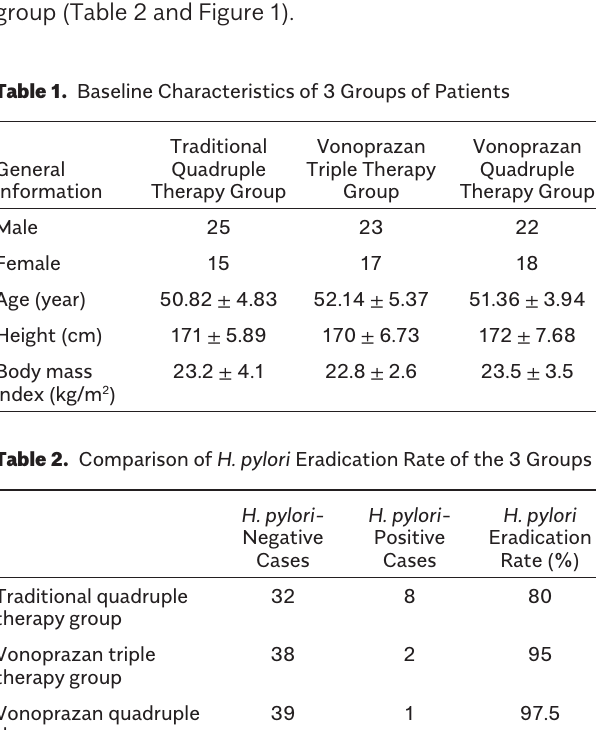
Table 1. Baseline Characteristics of 3 Groups of Patients